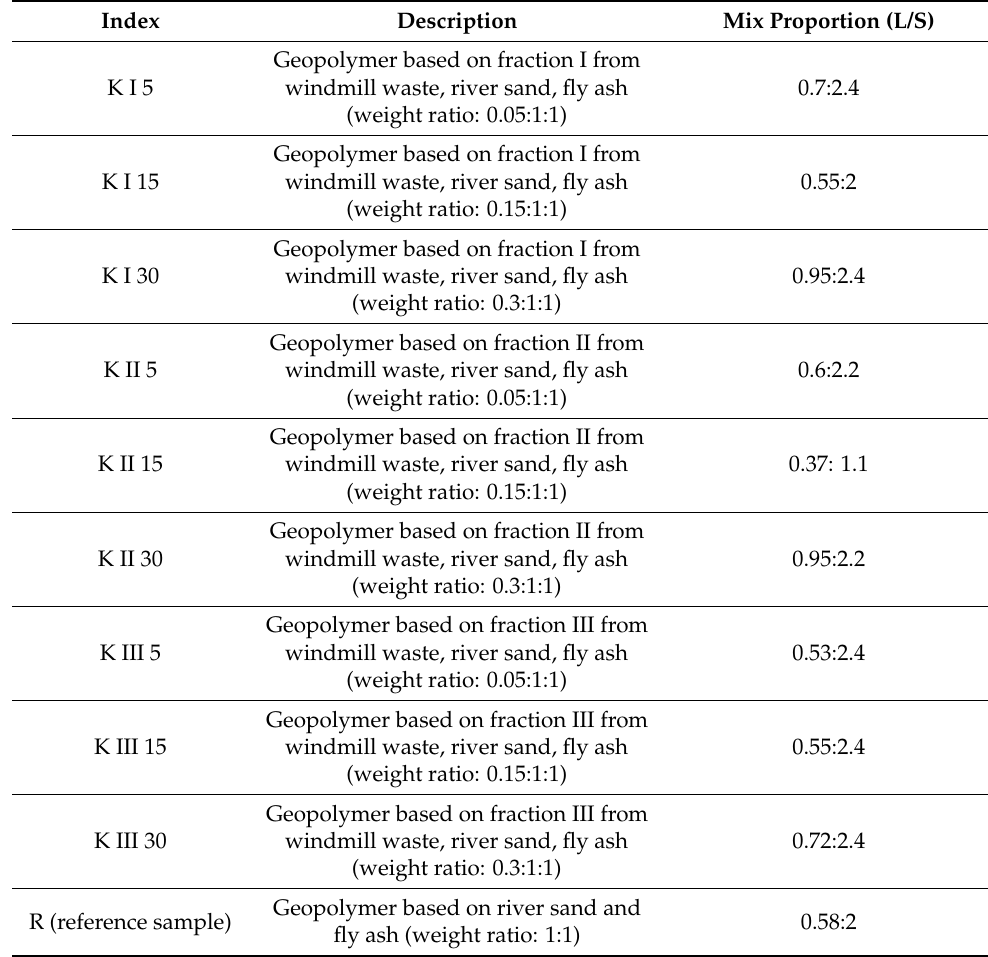
Table 1. List of geopolymers